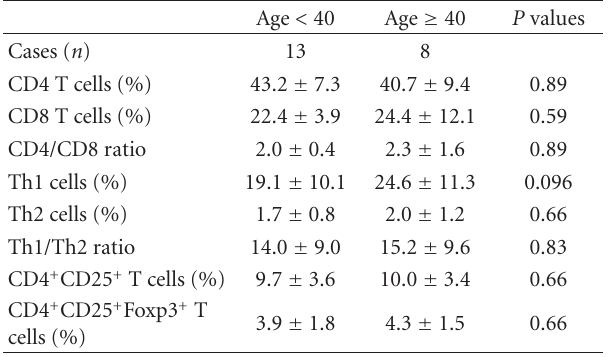
Table 2: The di ff erence of T-lymphocyte subsets between young and old subjects in control group. Age < 40 Age ≥ 40 P